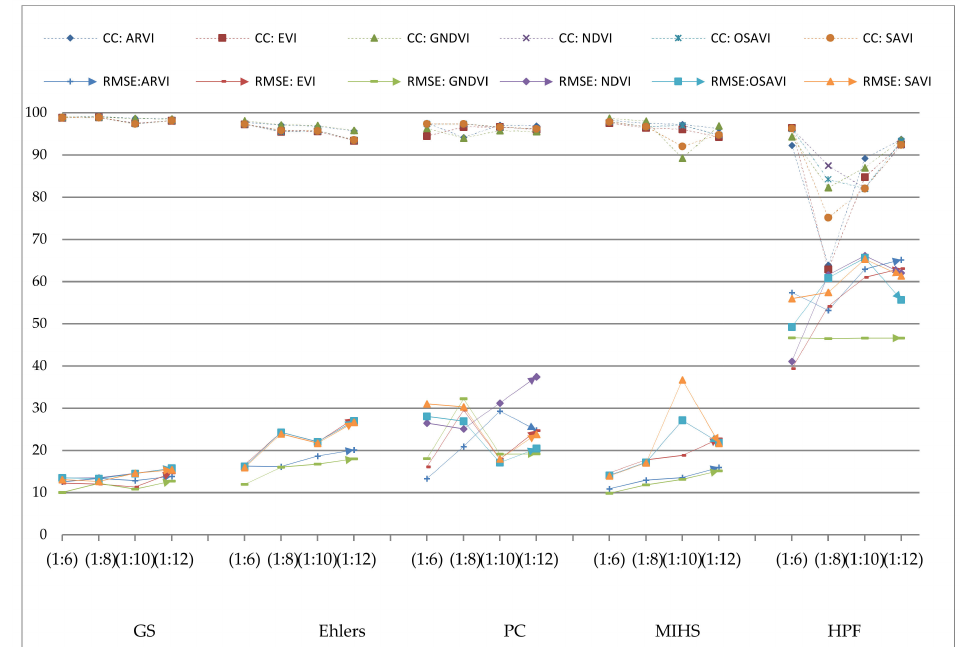
Figure 3. Trend of FVI quality with Image Fusion and SRR (same SRF and good